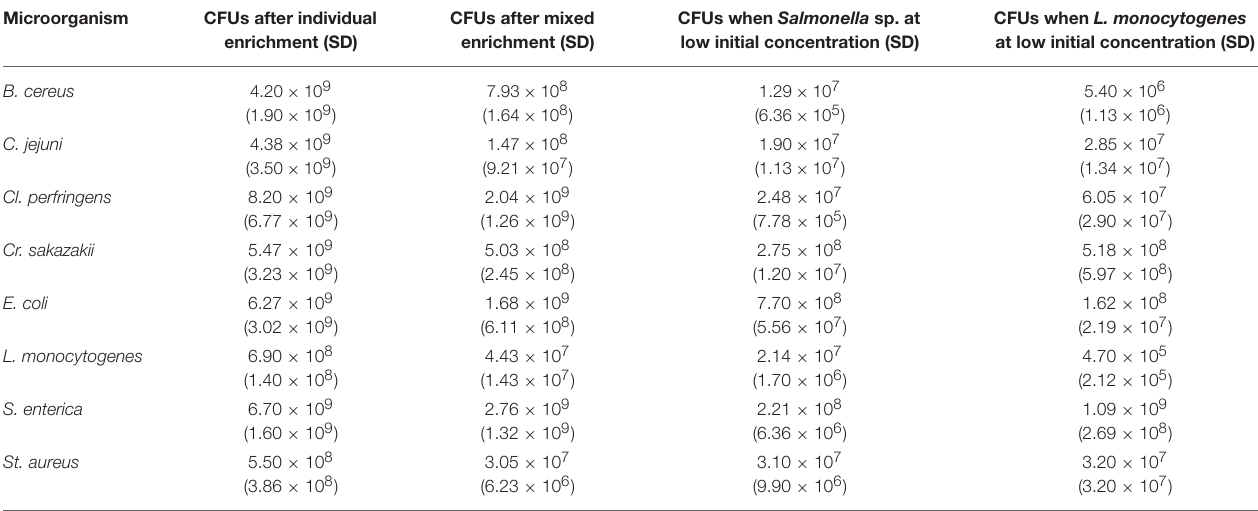
Microorganism CFUs after individual enrichment (SD)